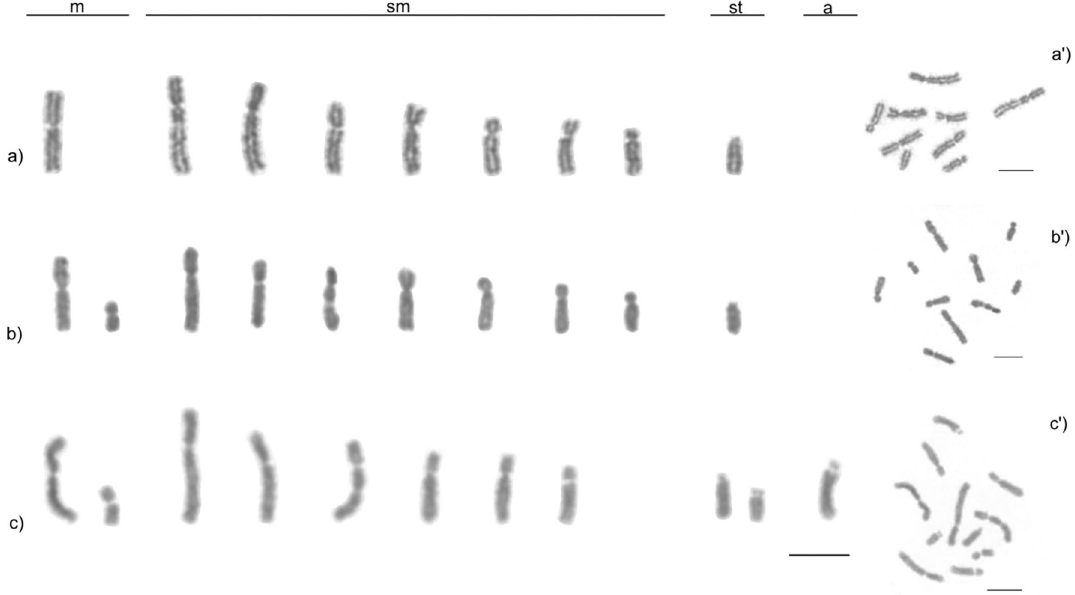
Figure 2. Karyotype and metaphase chromosomes, respectively, of asexual Mycocepurus smithii females organized according to their size and morphology . ( a , a ′ ) karyomorph 2n = 9 (1 m + 7sm + 1st); ( b , b ′ ) karyomorph 2n = 10 (2 m + 7sm + 1st); ( c , c ′ ) karyomorph 2n = 11 (2 m + 6sm + 2st + 1a). m metacentric, sm submetacentric, st subtelocentric, a acrocentric. Scale bar represents 5